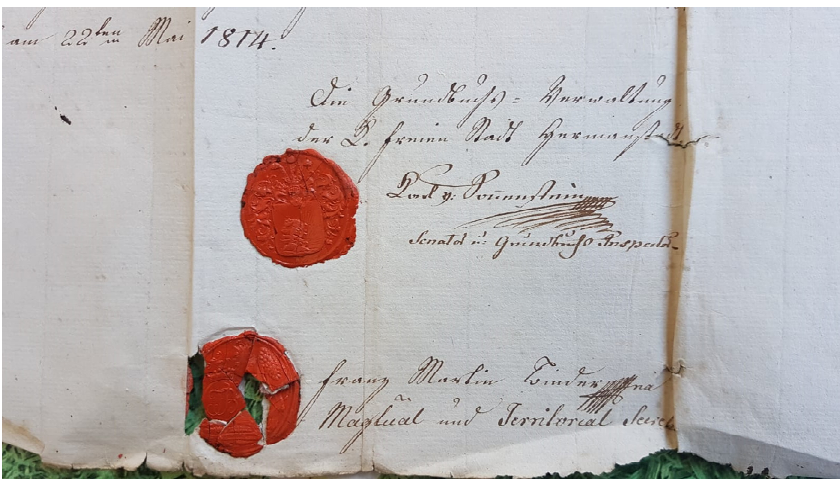
Figure 5. Wax stamps on page 2.